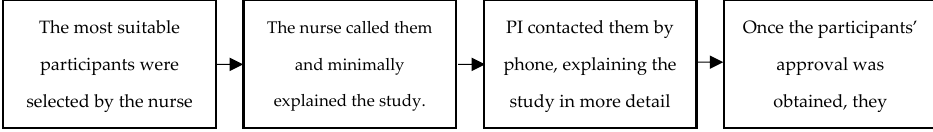
Figure 1. Sample selection process.